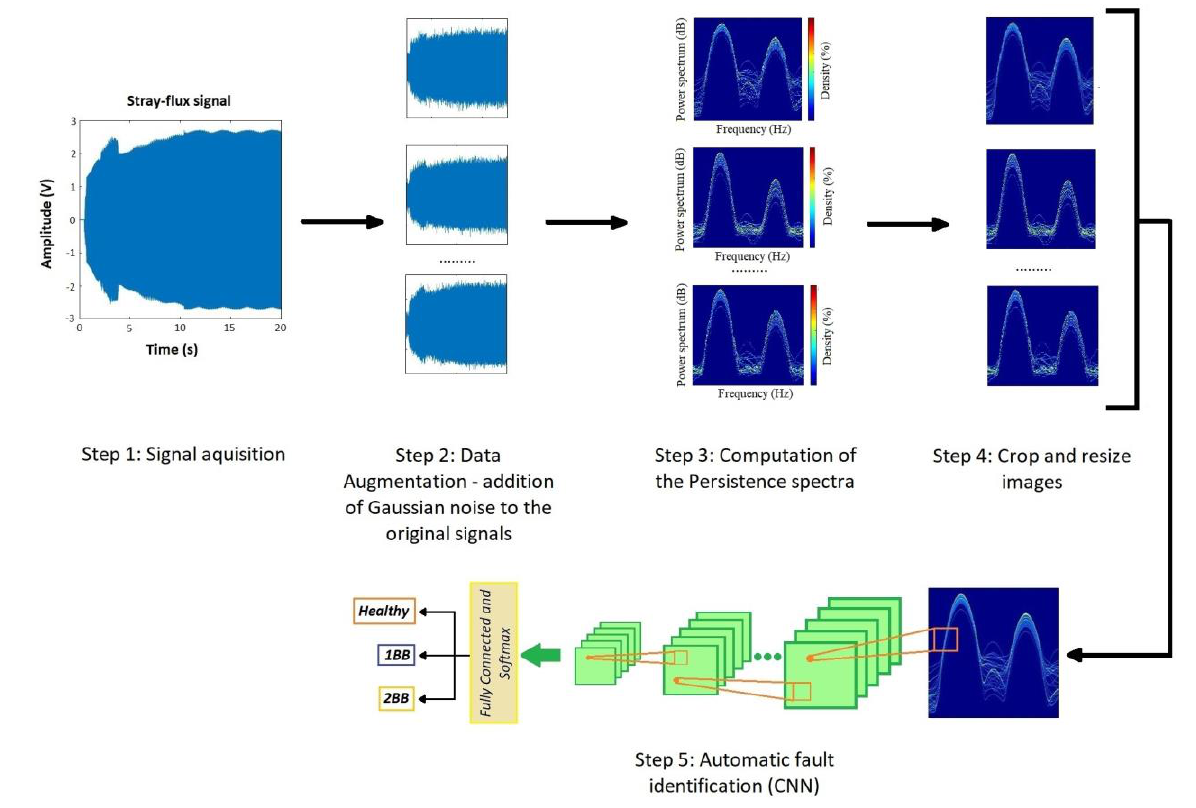
Figure 4. Proposed methodology overview.